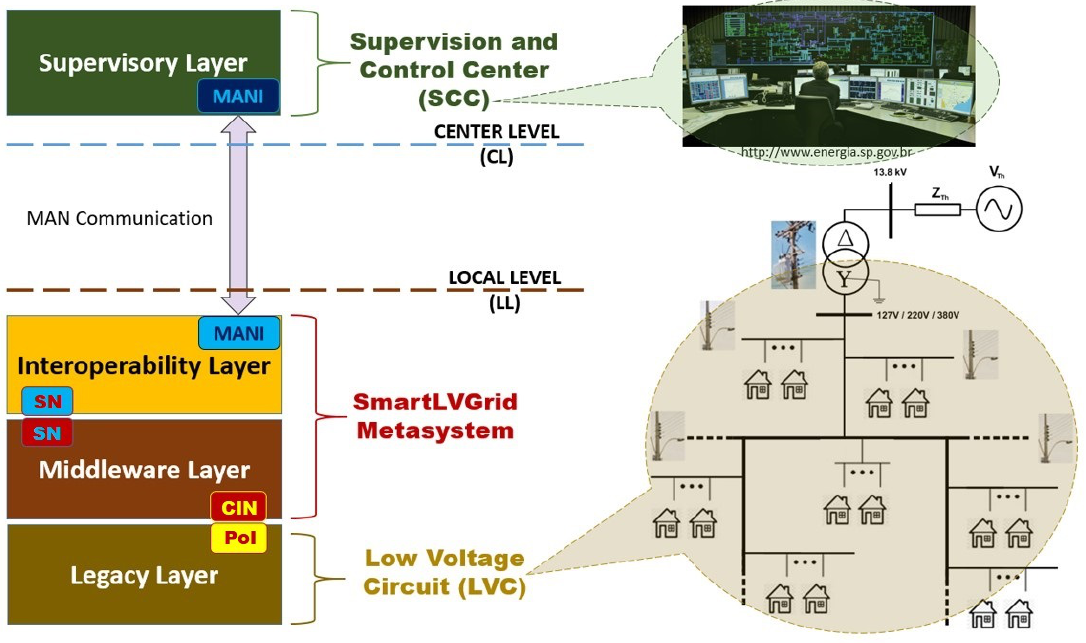
Figure 3. The SmartLVGrid stack and the composing elements of the distribution